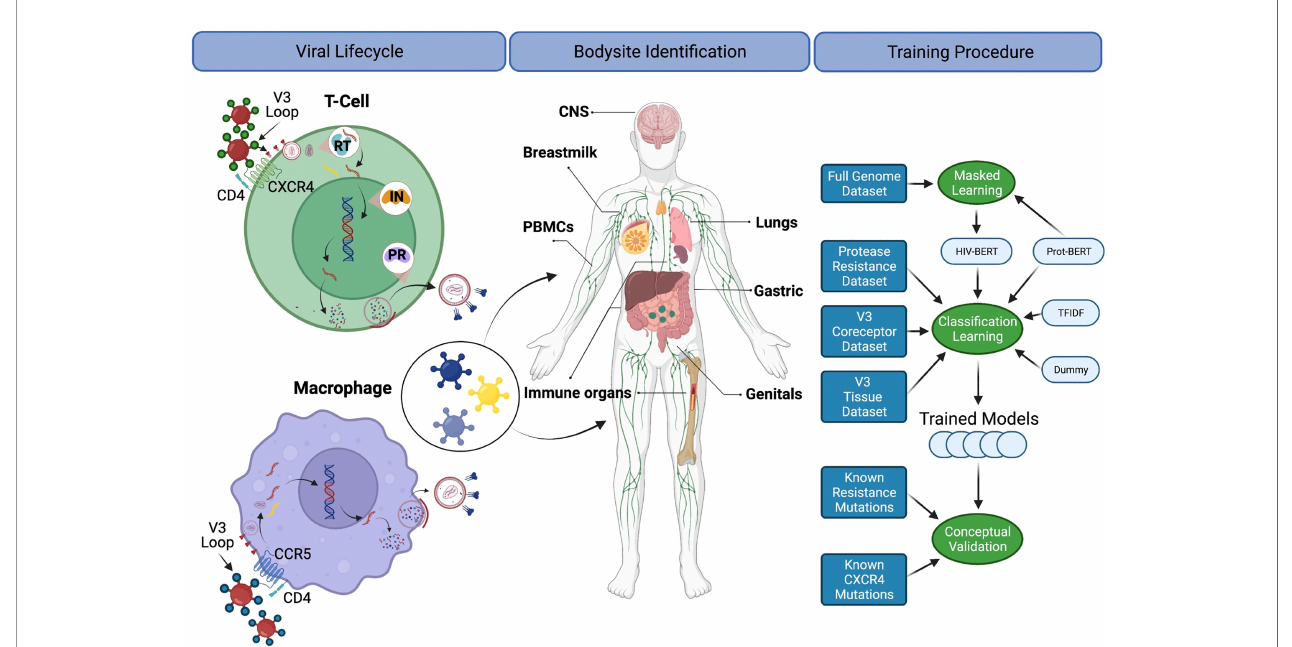
FIGURE 1 | A diagram for the biological processes explored. The left column depicts the basic viral lifecycle starting with entry through the binding of CD4 and cell- speci fi c coreceptors, followed by unpackaging of the capsid, reverse transcription of viral RNA, integration into the host genome, subsequent translation of viral proteins and repackaging. Steps where antiretroviral medications interfere with the lifecycle are also noted. The middle panel indicates bodysites that are known to be anatomic reservoirs of latent viral replication. The right panel shows a fl ow diagram of the experiments and training procedures described in the text. Figure created with